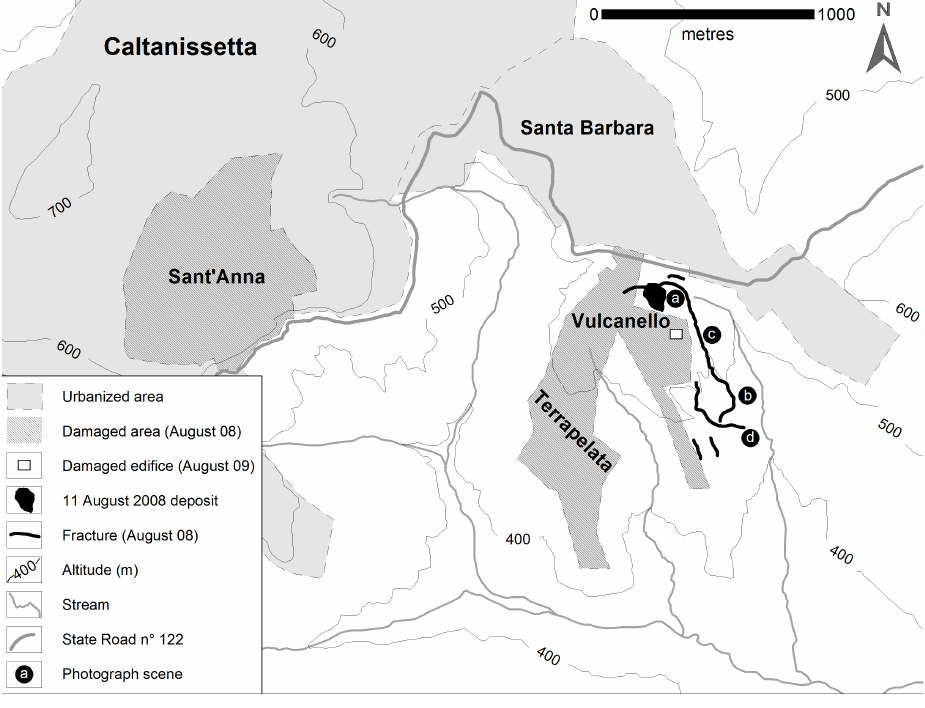
Fig. 2. Topographic map of Santa Barbara area, with localization of the main features and damaged areas related to mud volcanoes activity.